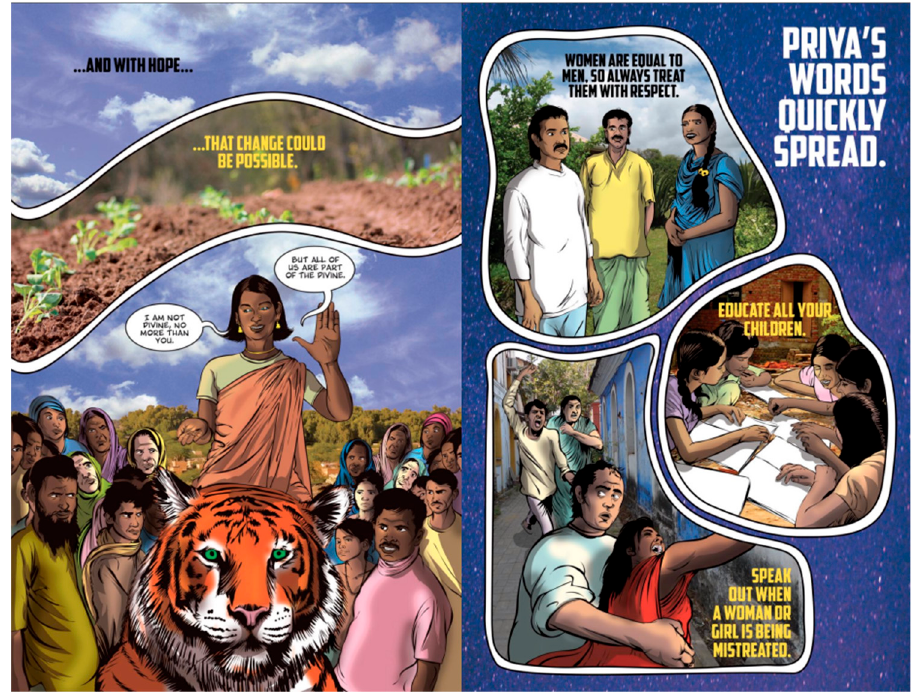
Figure 8. Priya begins a social movement across India drawing attention to the ways that society can address gender-based violence. Image Courtesy: Ram Devineni.